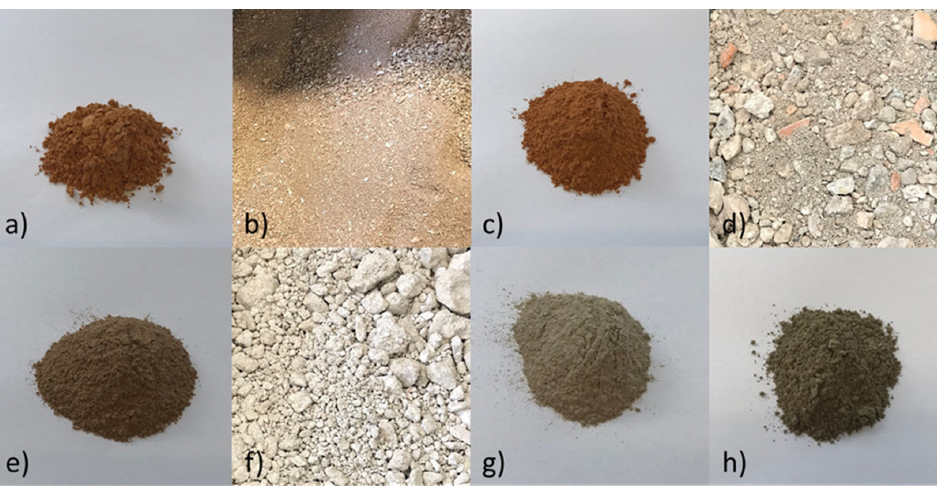
Figure 1. Waste materials used in the production of geopolymers: brick sanding dust ( a ); unprocessed brick scrap ( b ); processed brick scrap ( c ); unprocessed mixed rubble ( d ); processed mixed rubble ( e ); unprocessed concrete rubble ( f ); processed concrete rubble ( g ); fly ash ( h ).